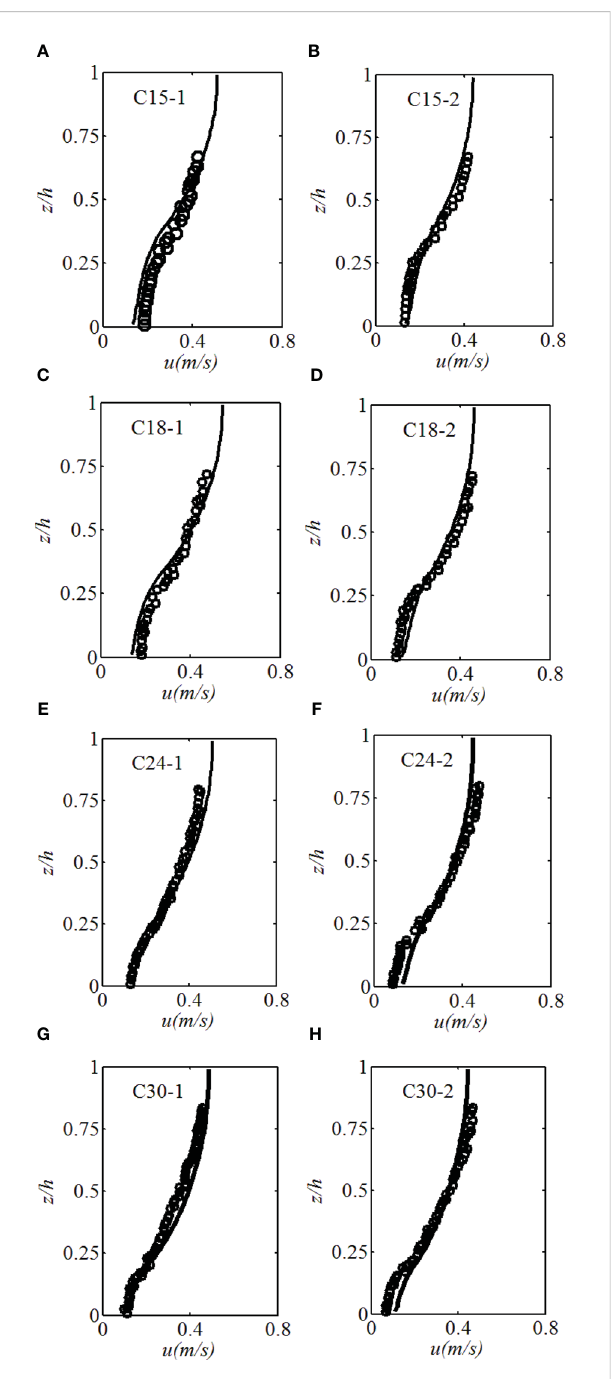
FIGURE 8 Comparisons of measured and simulated mean velocities in tests carried out by Lu (2008): (A) C15-1, (B) C15-2, (C) C18-1, (D) C18-2, (E) C24-1, (F) C24-2, (G) C30-1, (H) C30-2. c, which was affected by vertically varying cylinder density, the array- scale turbulence caused by both the multi-shear layers and stem-scale turbulence affected sediment suspension. The imposed waves increased sediment suspension compared to the results under different hydrodynamic conditions. The co-occurring waves greatly enhanced bottom shear stress and promoted sediment suspension, and the sediment concentration was found to be increased with the